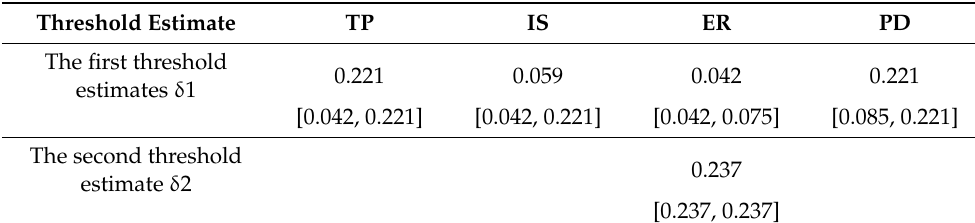
Table 7. Threshold estimates.